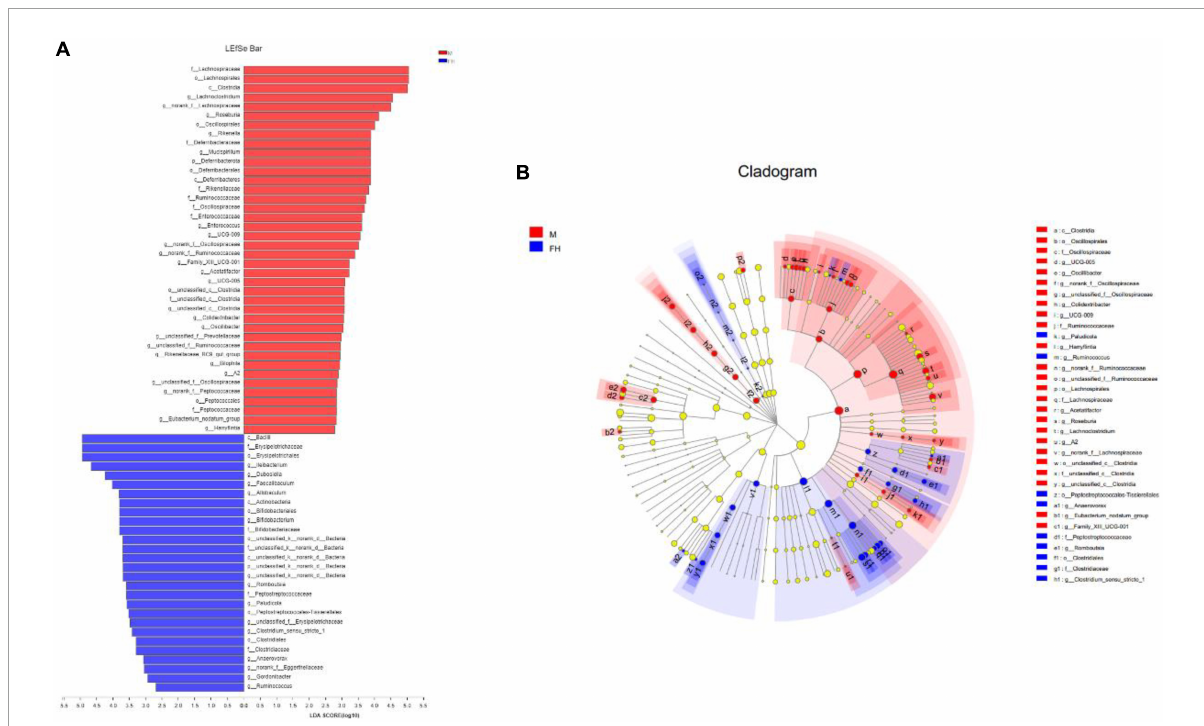
FIGURE7 LEfSe and LDA analyses based on OTUs characterized the microbiomes of the M and FH groups. (A) LDA scores show the significant bacterial differences between the FH and M (log LDA > 2.0; n = 5). (B) The branching diagram shows the phylogenetic distribution of bacterial lineages in the FAK intervention group and the model group. Different colored areas represent different components (red, M; blue, FH). Circles indicate phylogenetic levels from domain to genus. The diameter of each circle is proportional to the abundance of the